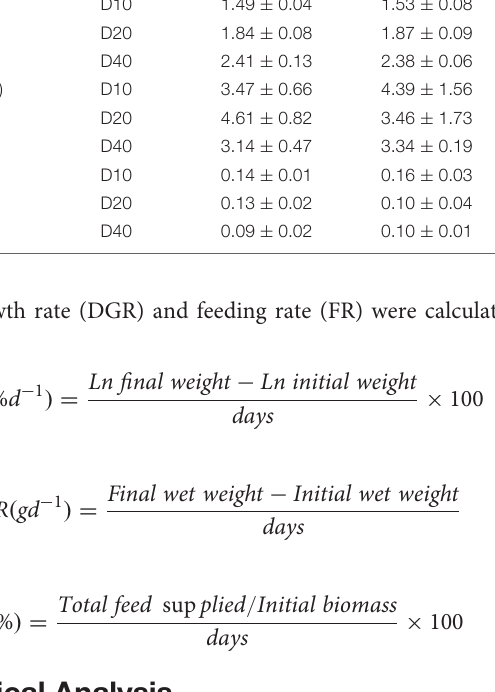
TABLE 1 | Feeding Rate (FR), Specific Growth Rate (SGR), and Daily Growth Rate (DGR) of Hediste diversicolor fed during 10, 20, and 40 days (D10, D20, and D40) with a commercial aquafeed under different combinations of temperature (T—20 and 25 ◦ C) and salinity (S—15, 20, and 25). Average values ( ± SD) ( n = 5). Performance